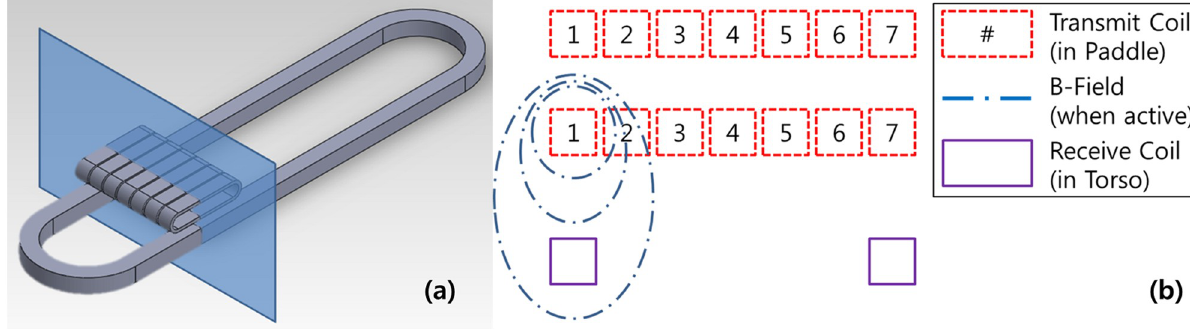
Fig 3. Concept of position measurement system. (a) arrangement of the receiving and transmitting coils; (b) concept of position measurement using inductance coupling.